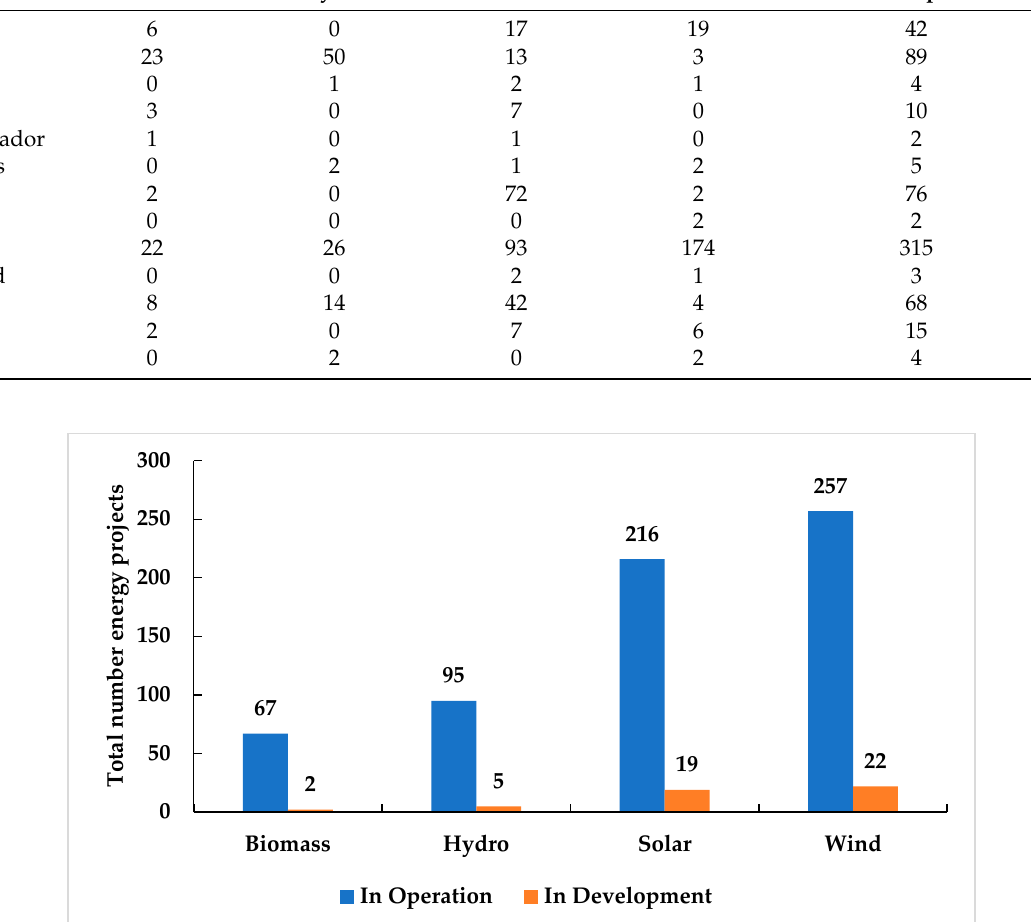
Figure 2. Number of biomass, hydro, solar, and wind projects in operation and development in Canada (2010–2021) [31,33,88].